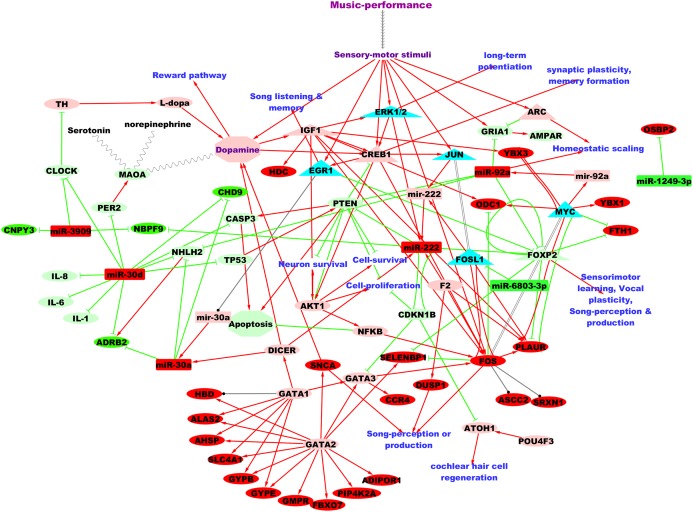
Putative TF:microRNA:gene regulatory network in professional music-performance.Candidate microRNAs are denoted by rectangles, target or other genes by ellipses and transcriptional regulators of candidate microRNAs by triangles. Green and red colour indicates down-regulation and up-regulation of the molecules (microRNAs and genes), respectively, after professional music-performance. Light-green and light-red colour nodes denote putative repression and activation, respectively, based on findings from microRNA databases and literature given in Discussion. Red arrows, green edges and black edges, respectively, show putative activation, repression and regulation. Solid and dotted arrows show direct and indirect interactions, respectively.